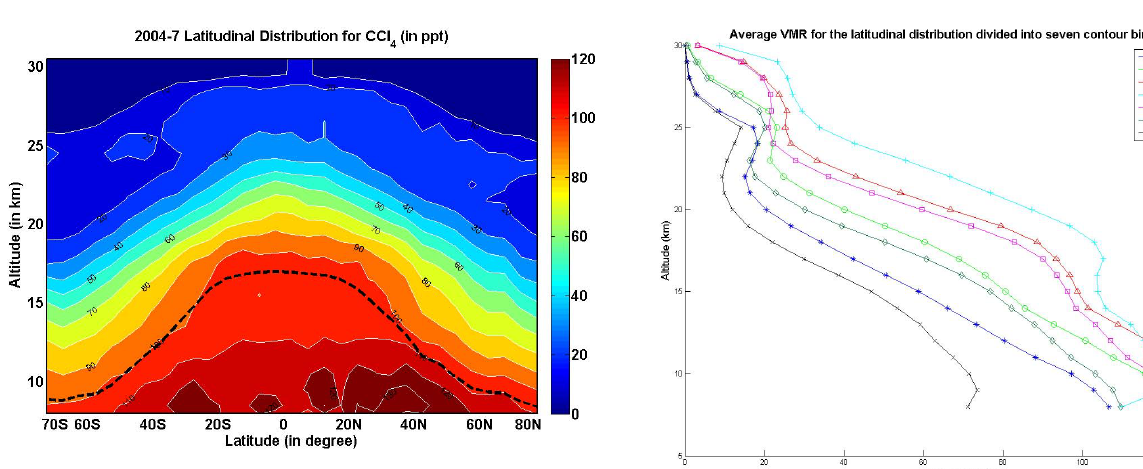
Fig. 4. The average volume mixing ratio (inppt) from ACE-FTS profiles spanning February 2004 to August 2007 for seven zonal regions: 60–90 ◦ S (black line with crosses), 45–60 ◦ S (dark green line with diamonds), 20–45 ◦ S (magenta line with squares), 20 ◦ S– 20 ◦ N (cyan line with plus signs), 20–45 ◦ N (red line with triangles), 45–60 ◦ N (light green line with circles) and 60–90 ◦ N (blue line with asterisks) are compared and displayed with respect to altitude between 8 to 30km. Polar measurements were not retrieved above 25km whilst in the tropics retrievals were made up to 30km. A priori profiles have been spliced on above the maximum retrieved value so all curves reach 30km; high altitude peaks near 25km are